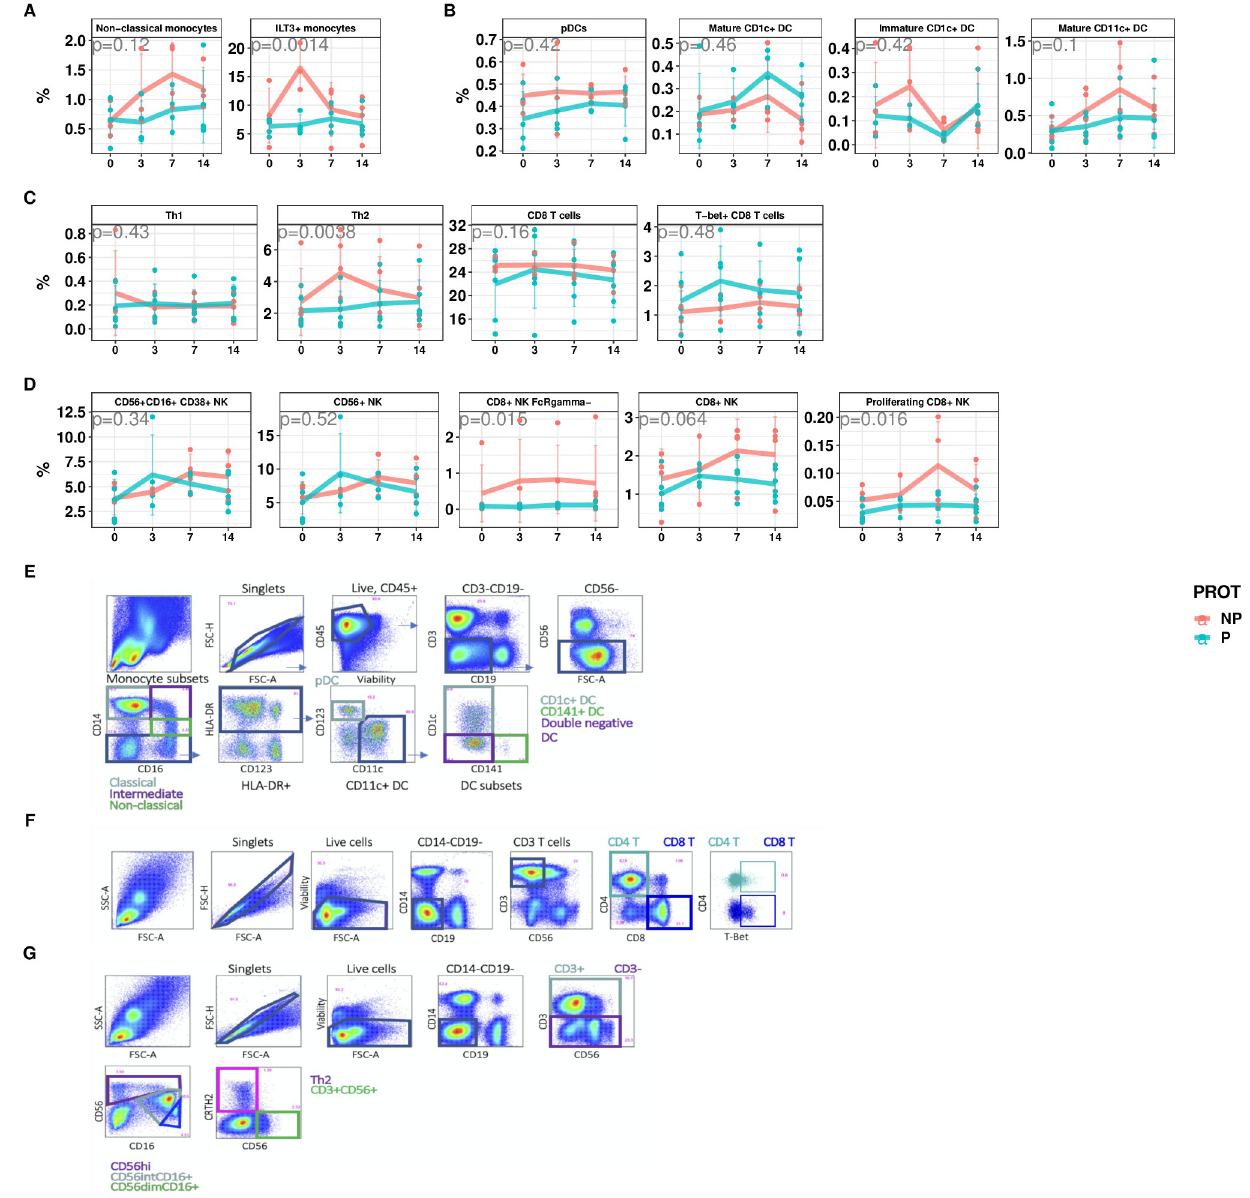
Fig 5. Temporal changes of specific cell types across time intervals in P and NP subjects. A-D. Flow-cytometry measured PBMC sub-populations percentages over time, stratified by protected (P: pink) and not-protected (NP: blue) status. A . non-classical monocytes and ILT3+ monocytes B. DCs C . T cells D. NK cells. Points represent cell proportion values in each subject. Line represents average values across P and NP subjects, with error bars indicating +/- SD. P-values derived from from ANOVA comparison of nested mixed models with and without protection term. E-G . Flow cytometry gating schemes E . DC subsets and monocytes F . Th1 and Th2 cells G . NK